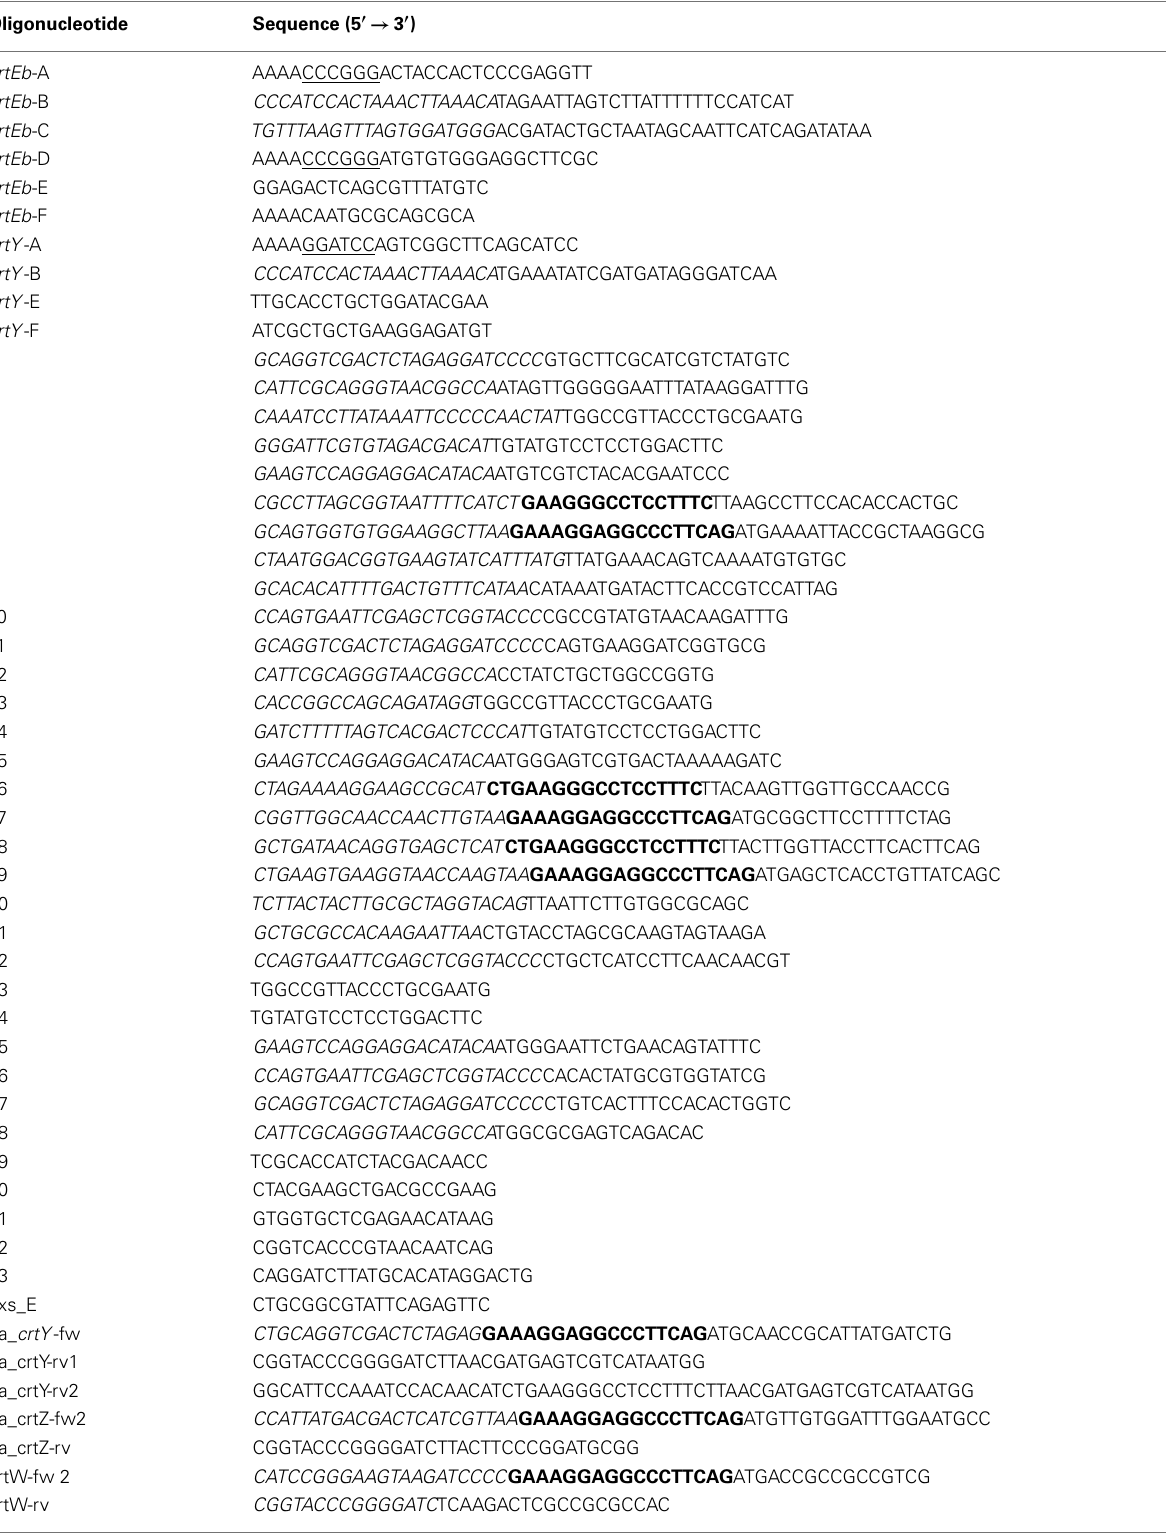
Table 2 | Oligonucleotides used in this study.